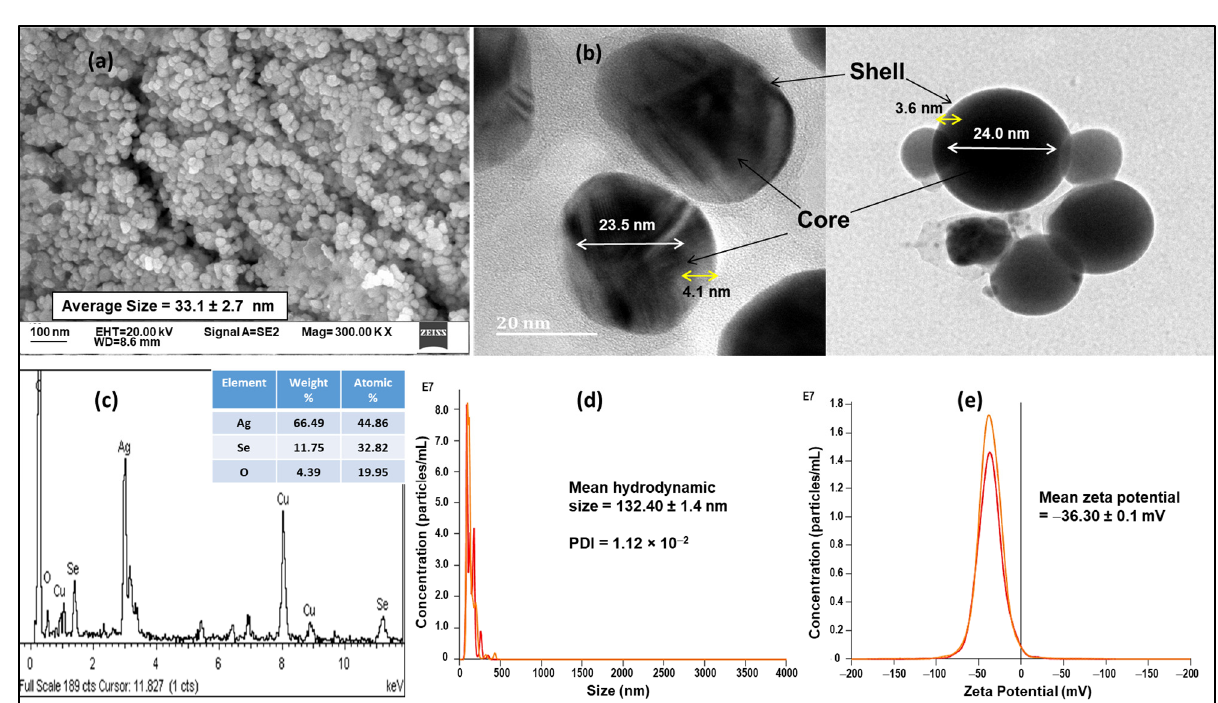
Figure 2. ( a ) Scanning electron microscopy (SEM) image of Ag@Se NPs, ( b ) High resolution-transmission electron microscopy (HR-TEM) image of Ag@Se NP core-shell, ( c ) HR-TEM- energy dispersive x-ray (EDX) spectrum of Ag@Se NPs by weight and atomic percent, ( d ) Ag@Se NP concentration and size from nanoparticle tracking analysis (NTA) and, ( e ) Ag@Se NP concentration and zeta potential from NTA.